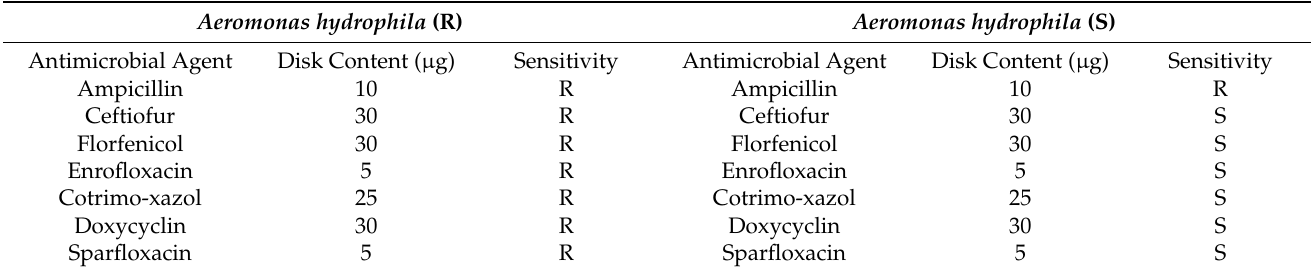
Table 1. Antibiotic-resistant (R) and sensitive (S) strains of A. hydrophila .